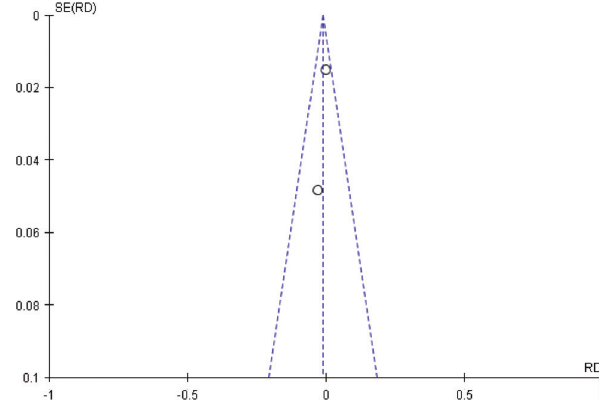
Figure 9 - Funnel plot of major complications in randomized studies. All studies are inside the funnel plot.